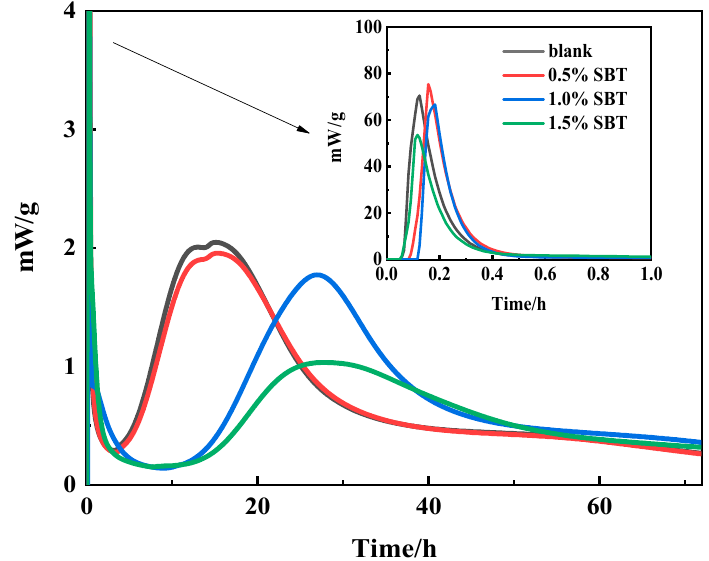
Figure 4. Heat map of hydration of cement paste.